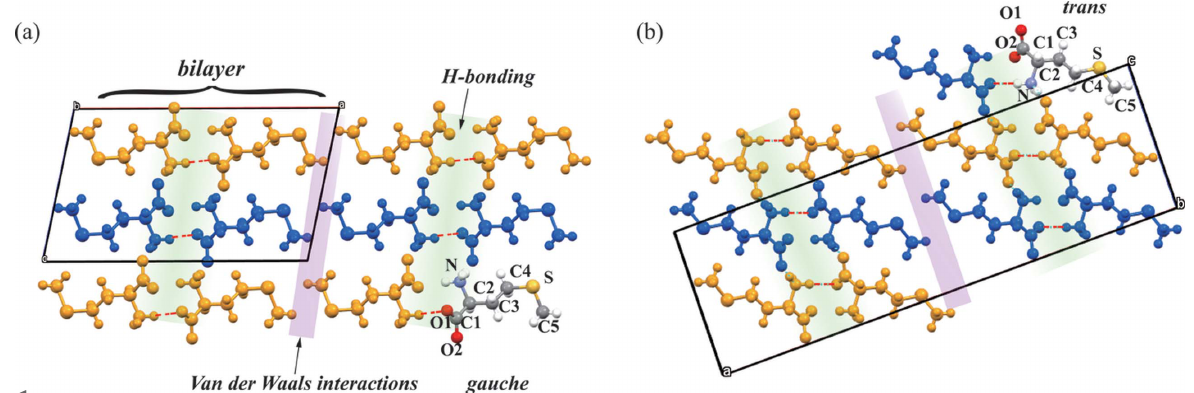
Figure 1 Schematic of DL-MET crystal structures of the ( a ) (cid:2) polymorph (CSD entry DLMETA07, only the major conformation is displayed) and ( b ) (cid:3) polymorph (CSD entry DLMETA09) viewed along the b